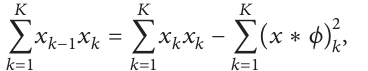
Figure 3 sums up the global method of artifact filtering and the various parameters which influence filtering.